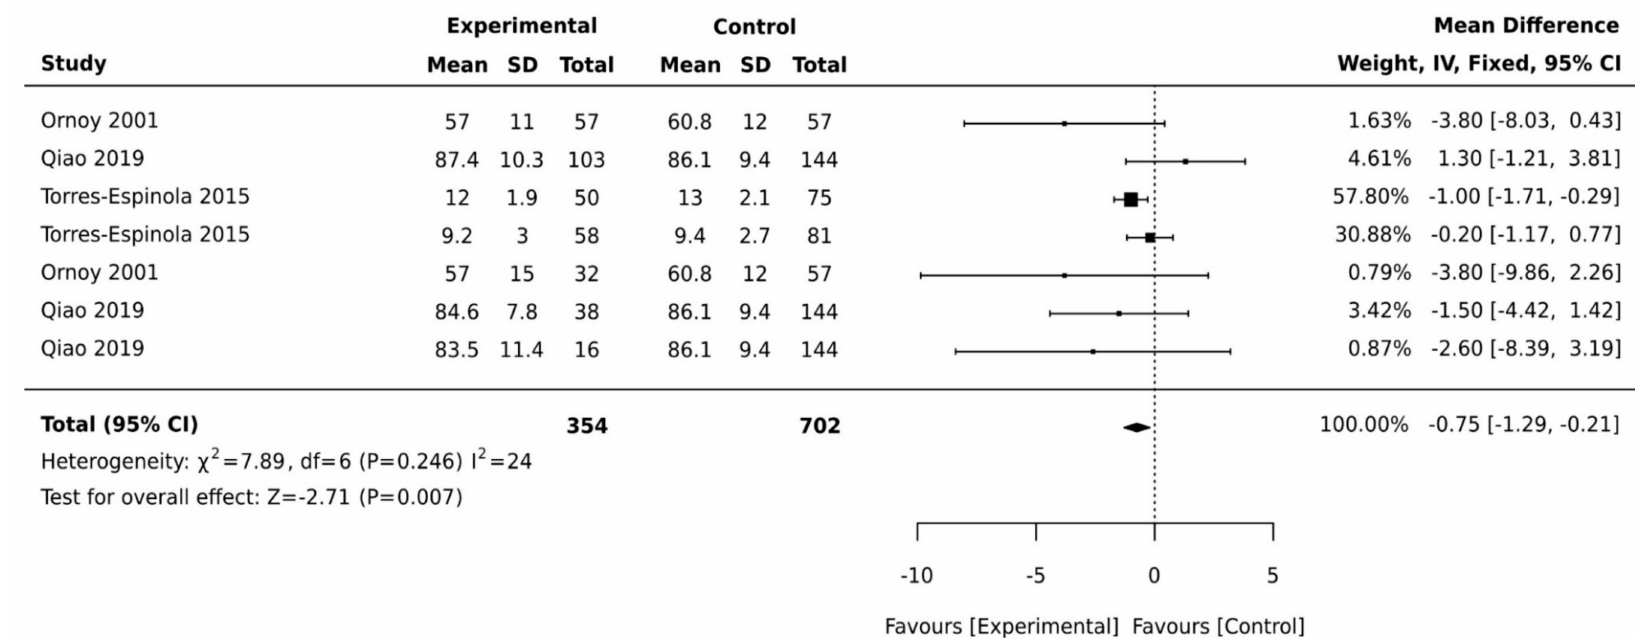
Figure 3. Forest plots comparing the differences in gross motor development between children born to mothers with and without maternal